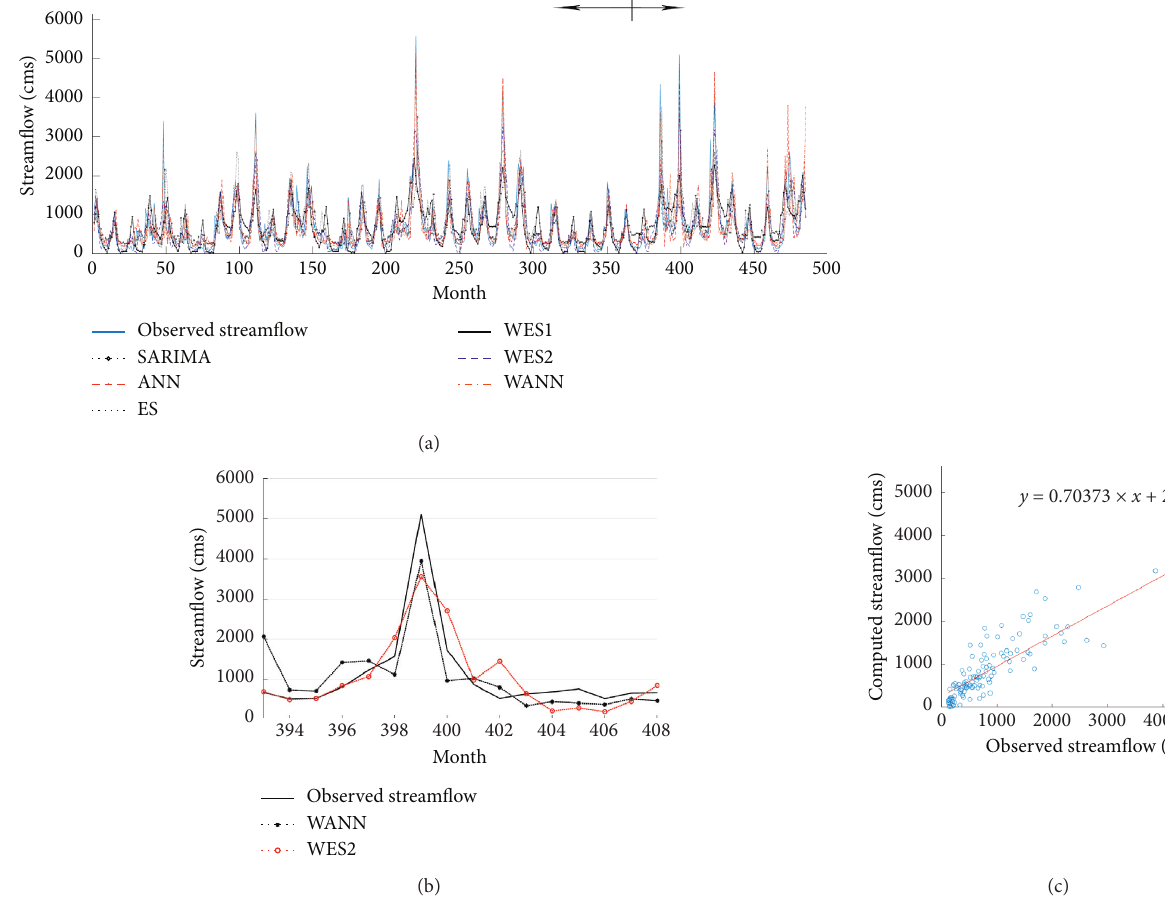
Figure 8: Observed/simulated monthly streamflow of West Nishnabotna. (a) Whole. (b) Detail. (c) Verification scatter plot of WES